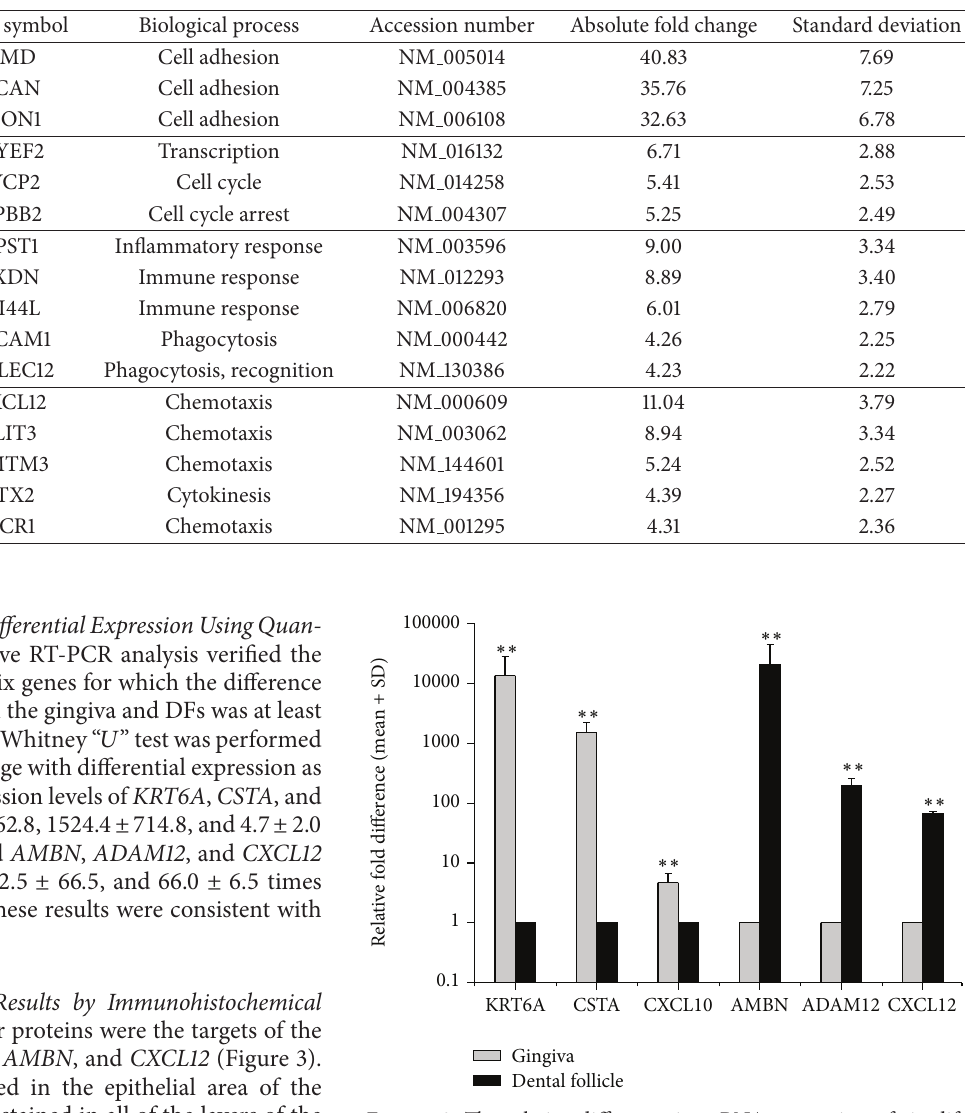
Figure 2: The relative difference in mRNA expression of six dif- ferentially expressed genes between the gingiva and dental follicles using quantitative RT-PCR. The data are presented as the mean + standard deviation and expressed as the relative change by applying the equation 2 −ΔΔ Ct . 𝑦 -axis: a log scale measure. ∗∗ 𝑝 < 0.05